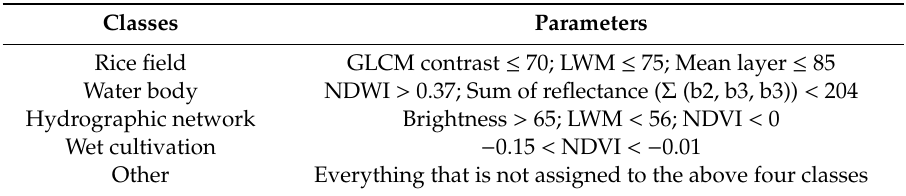
Table 1. Classification parameters for land